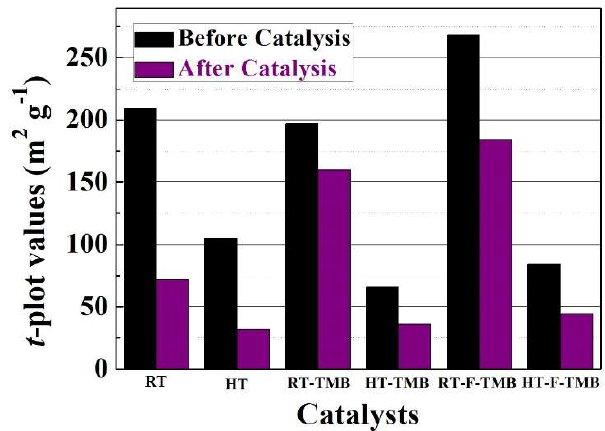
Figure 6. Comparison of the t -plot values (m 2 g −1 ) before and after the MPV reaction. (Experimental conditions: 0.1 g of catalyst, reaction temperature: 110 °C, reaction time: 6 h, i -POH/FUR molar ratio: 50, FUR/Catalyst mass ratio: 1).